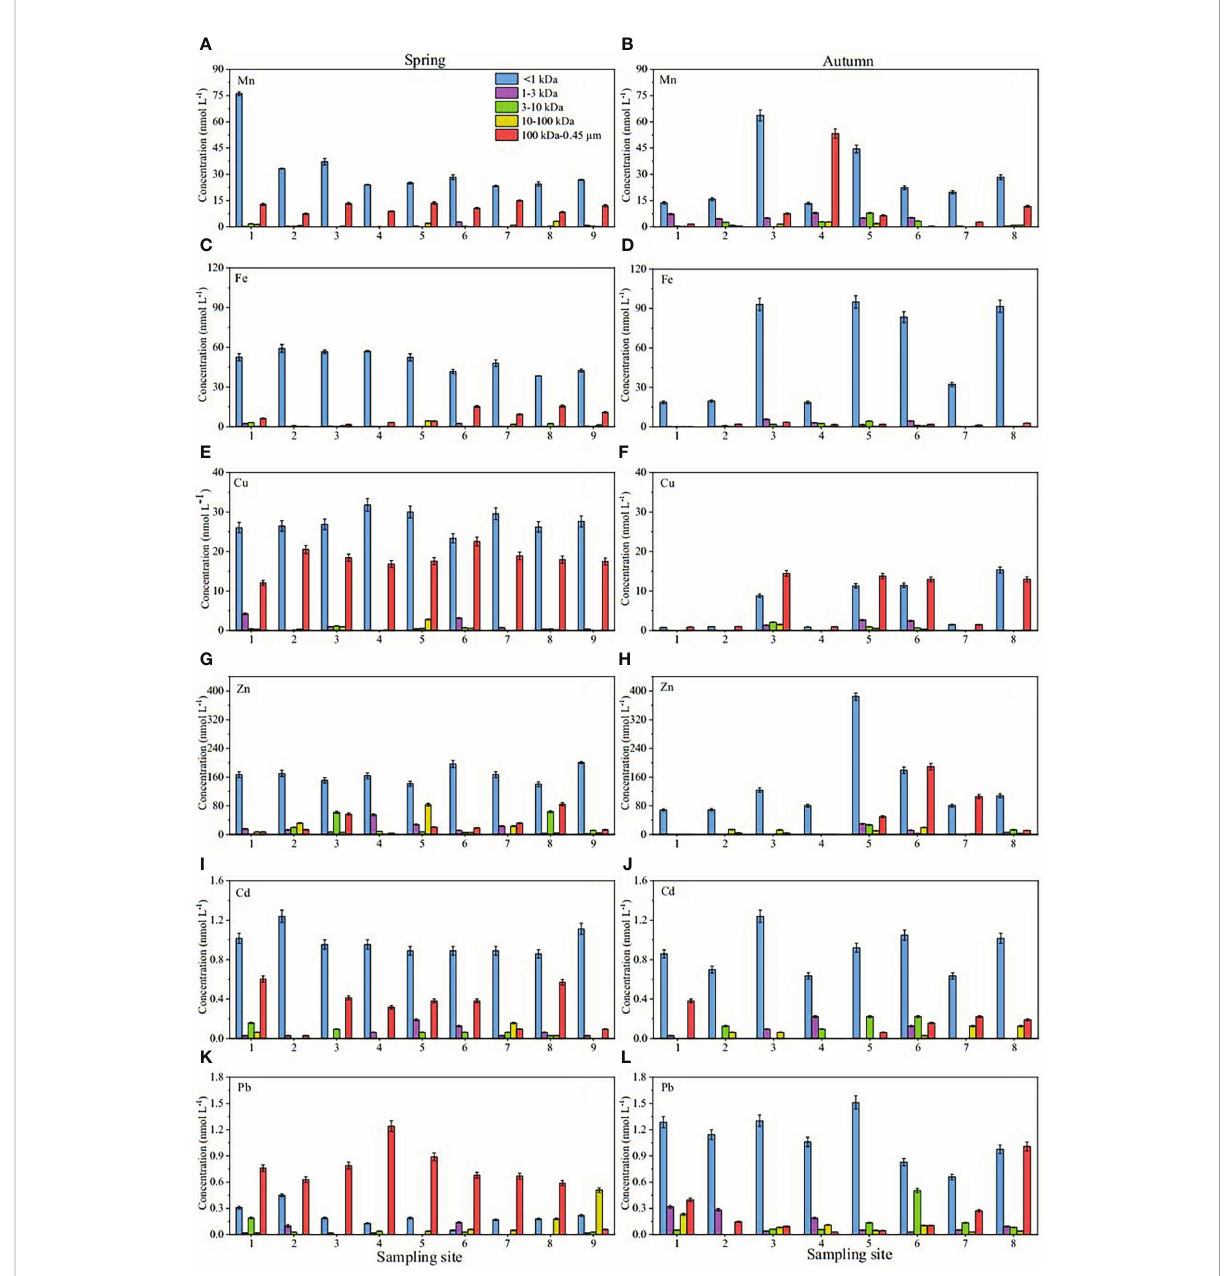
FIGURE 5 Concentration distribution of Mn, Fe, Cu, Zn, Cd and Pb at different sites in surface waters of the Yellow River Estuary in spring (A, C, E, G, I and K) ; autumn (B, D, F, H, J and L)